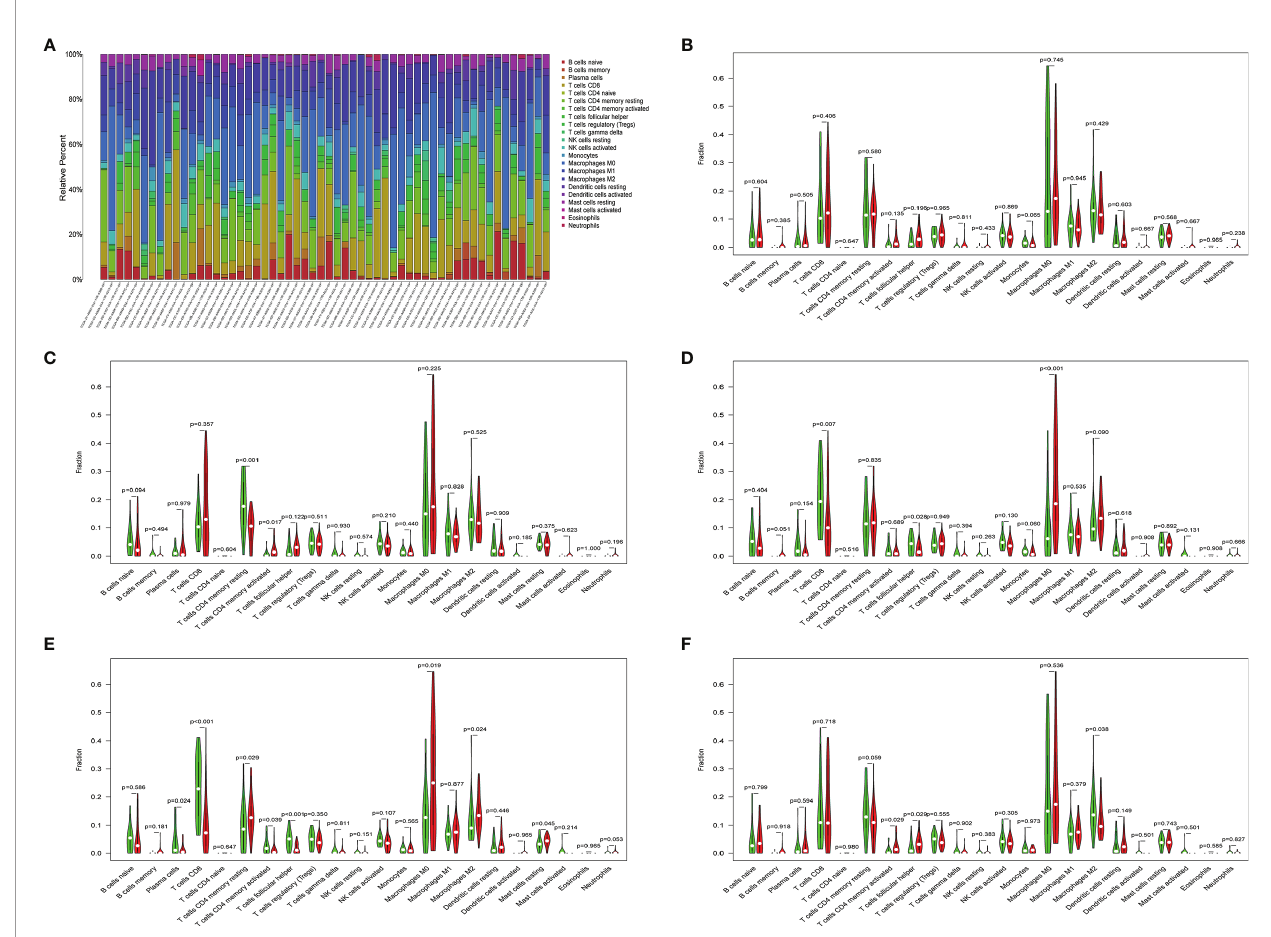
FIGURE 8 | (A) Histogram of immune cells. The abscissa is the sample selected from the TCGA-LIHC cohort (screening condition: P < 0.05), and the vertical row represents the composition of various immune cells in the sample. Each color represents a different cell type. (B – F) Violin diagrams of fi ve genes for constructing the model, including HDAC1 (B), BIRC5 (C), SPP1 (D), STC2 (E) and NR6A1 (F) . There are 22 kinds of immune cells on the abscissa, and the ordinate represents the content of immune cells. The red area represents the high expression group of genes, and the green area represents the low expression group of